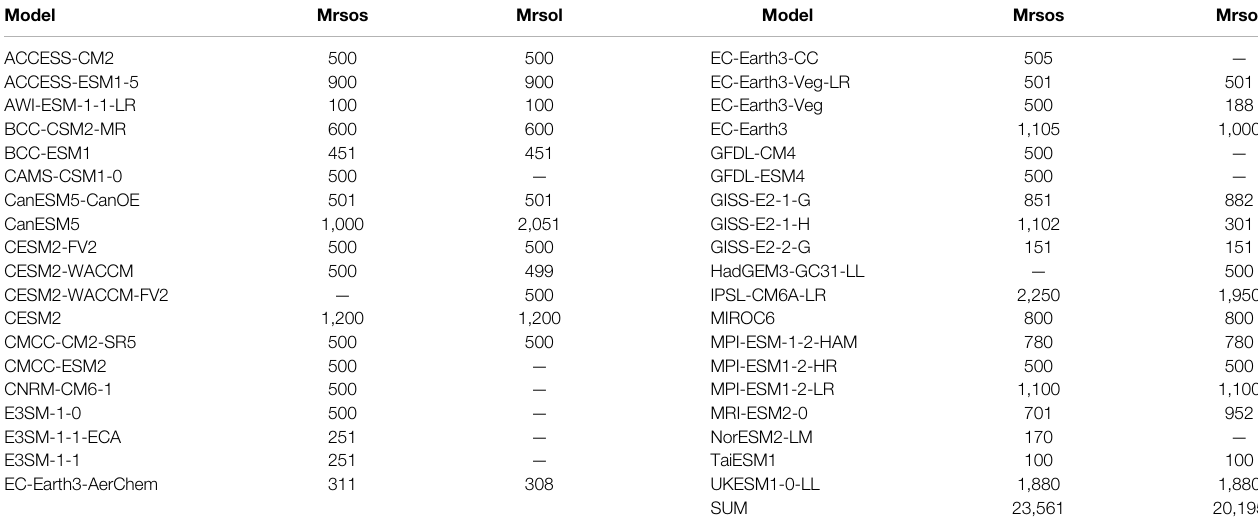
TABLE3| ListofCMIP6pi-controlexperimentusedtoestimateinternalclimatevariabilityinthisresearch.The fi rstandfourthcolumnsincludemodelnames,thesecondand fi fth columns include the total years of mrsos (moisture in the upper portion of the soil column) in pi-control experiment, and the third and sixth columns include the total years of mrsol (total water content of the soil layer) in pi-control experiment.